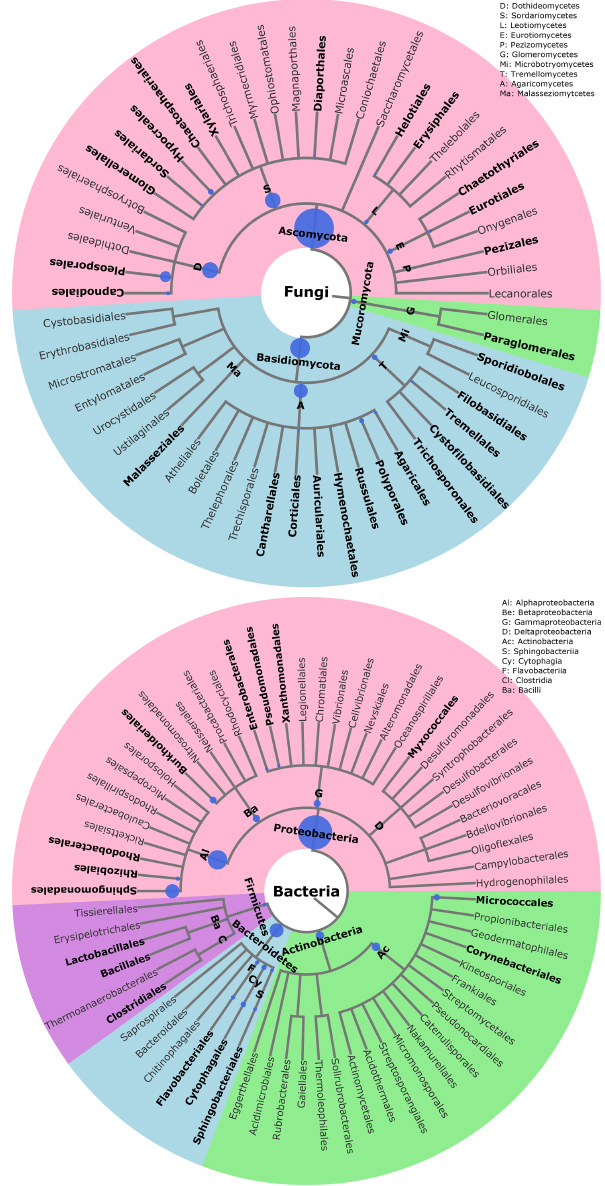
Figure 3. Taxonomic and phylogenetic trees of fungal and bacterial community structures in PM 10 at the study site. Phylogenetic trees are analyzed with the Environment for Tree Exploration (ETE3) package implemented in Python (Huerta-Cepas et al., 2016). The circle from the inner to the outer layer represents classification from kingdom to order successively. Further details on fungal and bac- terial taxa at genus level are provided in Fig. S4. The node size represents the average relative abundance of taxa. Only nodes with relative abundance ≥ 1 are highlighted in